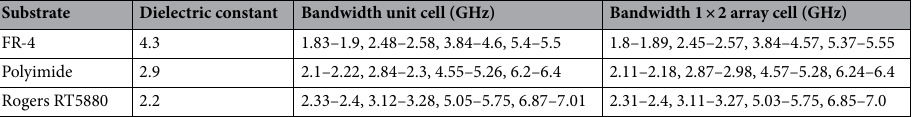
Table 3. Bandwidth specification for unit cell and 1 × 2 array cell.